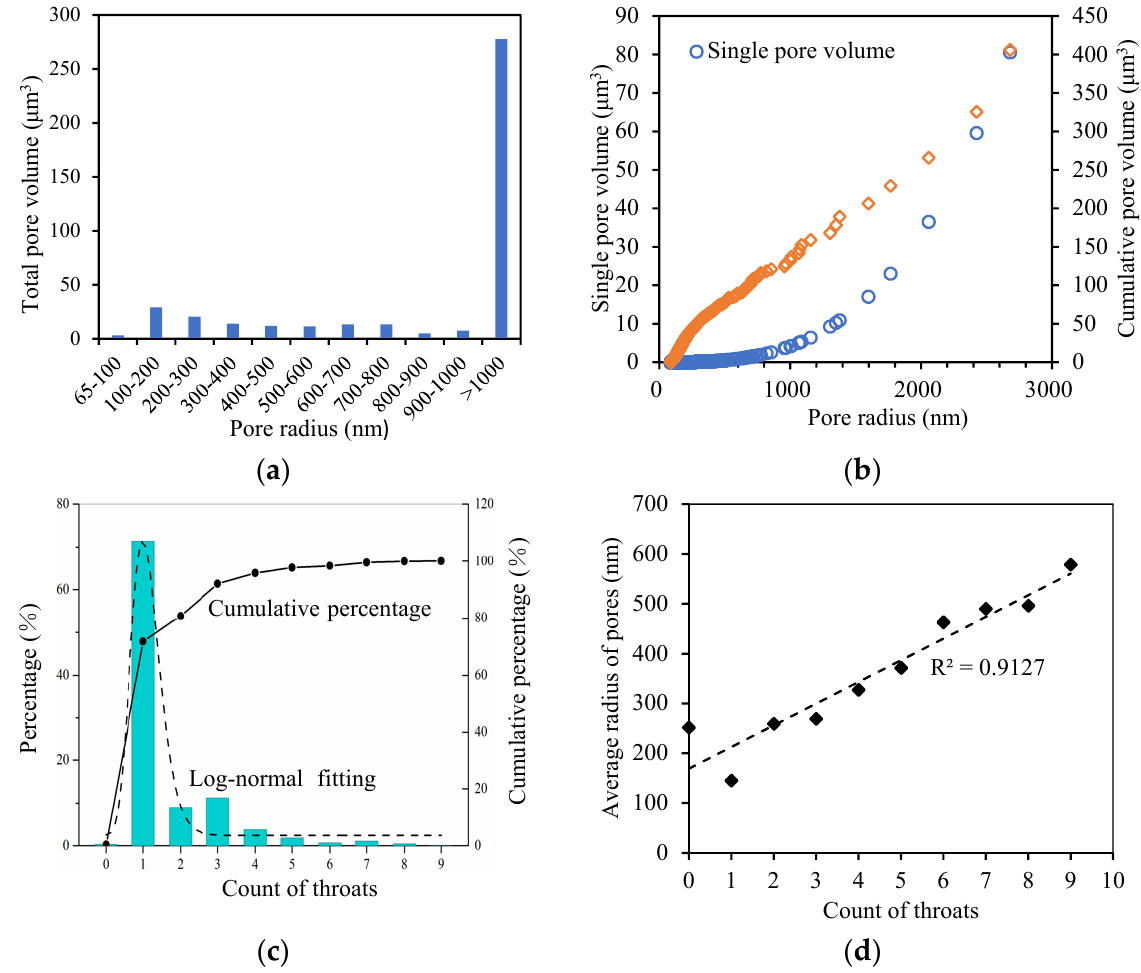
Figure 9. Characteristics of nano-scale pores. ( a ) total pore volume distributions; ( b ) single pore volume distributions and cumulative pore volume distributions; ( c ) pore throat distribution; ( d ) relationship between the size of pores and the number of pore throats.